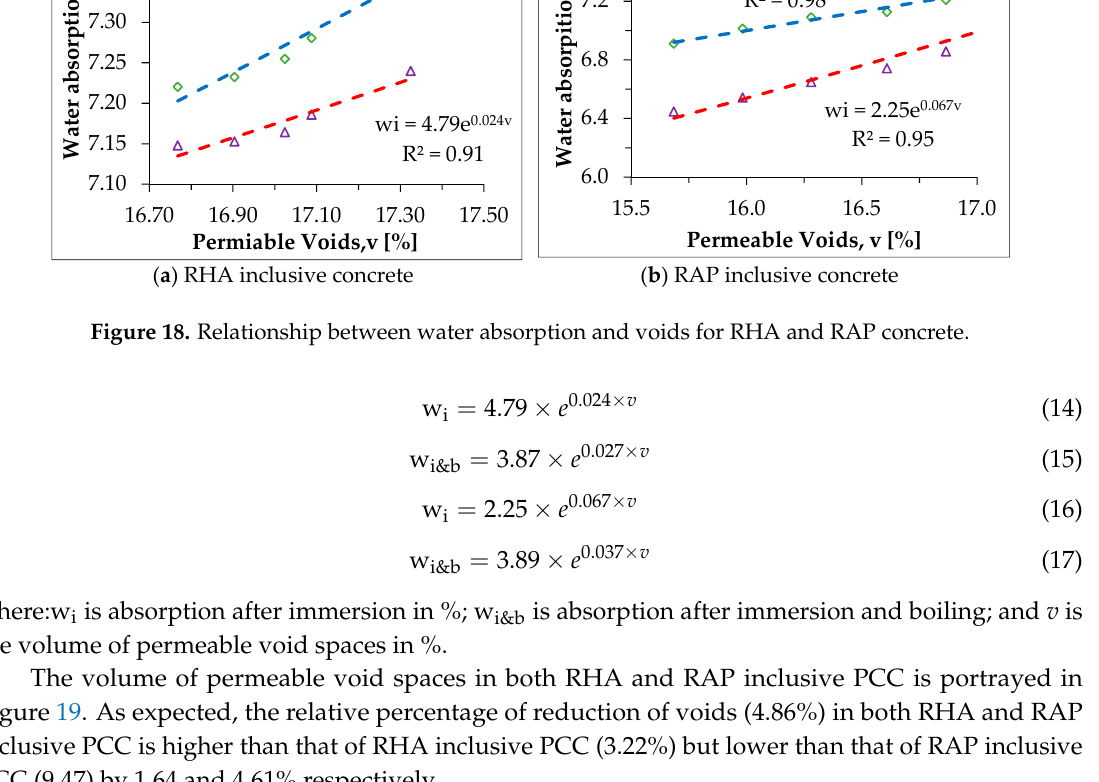
Figure 19. As expected, the relative percentage of reduction of voids (4.86%) in both RHA and RAP inclusive PCC is higher than that of RHA inclusive PCC (3.22%) but lower than that of RAP inclusive PCC (9.47) by 1.64 and 4.61% respectively.